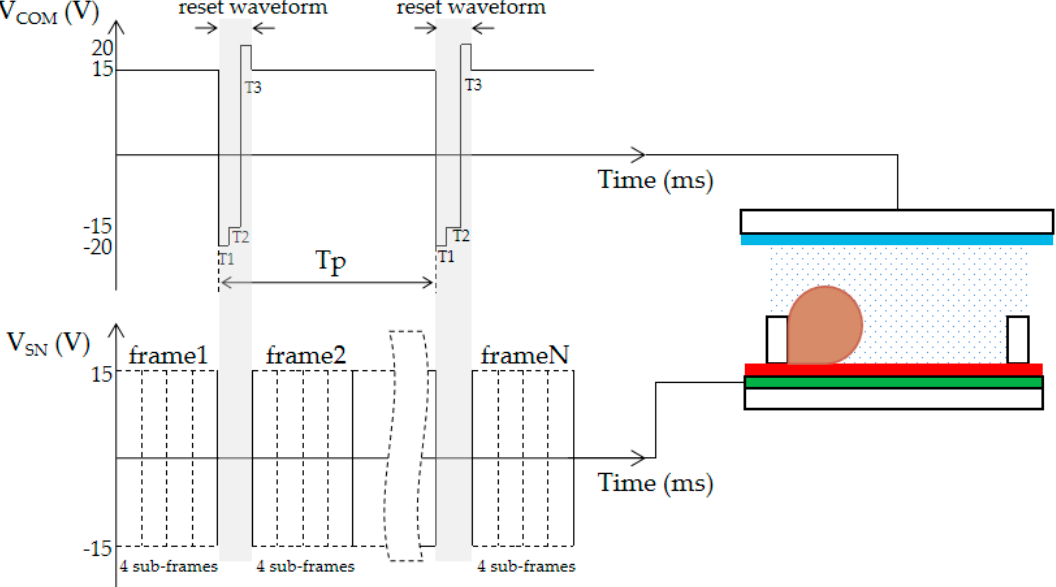
Figure 4. Reset waveform generated by the VCOM. The output of the reset waveform is controlled by the frame detection module in the system. The reset period is dynamically adjusted according to the displayed content.